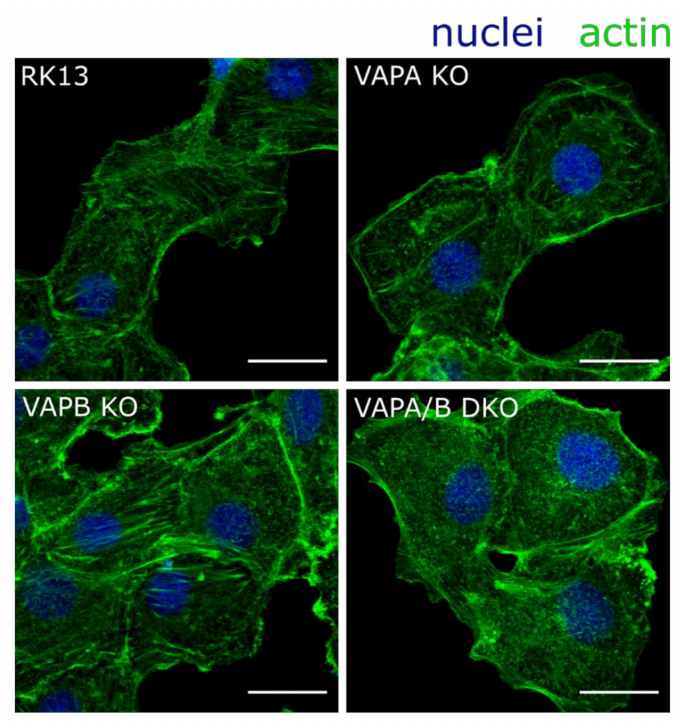
Figure 3. Actin organization is perturbed in RK13-VAPA/B DKO cells. RK13, RK13-VAPA KO, RK13- VAPB KO and RK13-VAPA/B DKO cells were fixed with 4% paraformaldehyde and cytoskeletal actin was stained with fluorophore-conjugated phalloidin (green). A loss of actin stress fibers and an accumulation of actin comets is obvious in RK13-VAPA/B DKO as reported for HeLa cells lacking VAPA/B [55]. Nuclei were counterstained with DAPI (blue). Shown are representative images. Scale bar = 20 µ